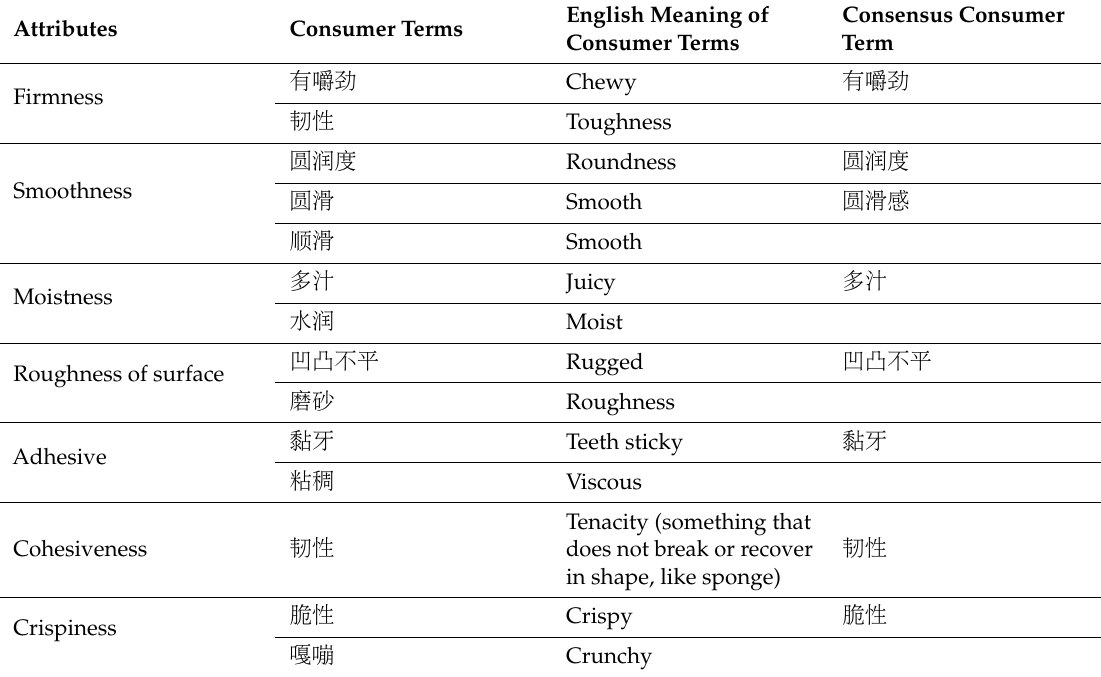
Table 7. Consumer texture terms provided by the Mandarin-speaking group